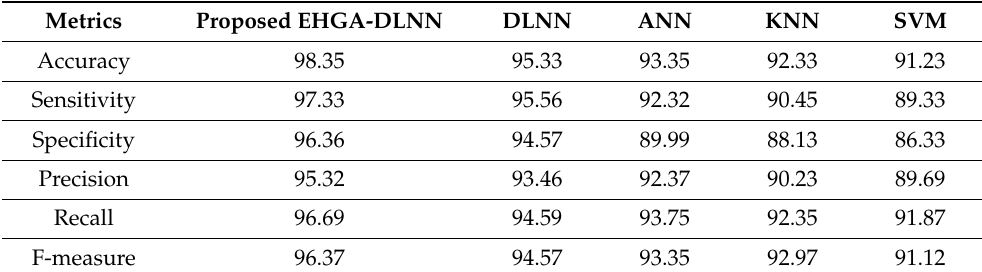
Table 1. The proposed method’s performance with the existing approaches.